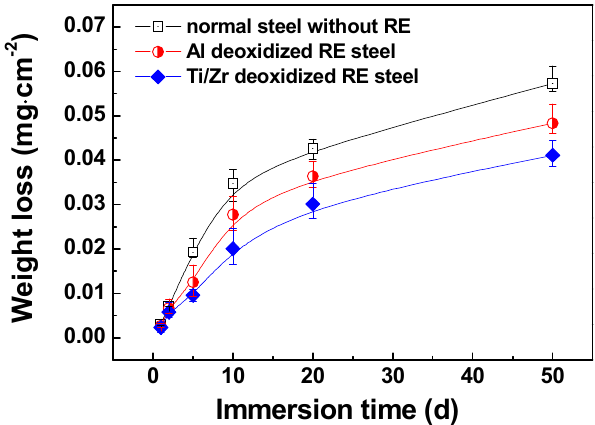
Figure 2. Corrosion weight loss of steels in a 3.5 wt.% NaCl solution. Table 2. Corrosion current density and corrosion potential obtained from potentiodynamic polarization curves in Figure 1.